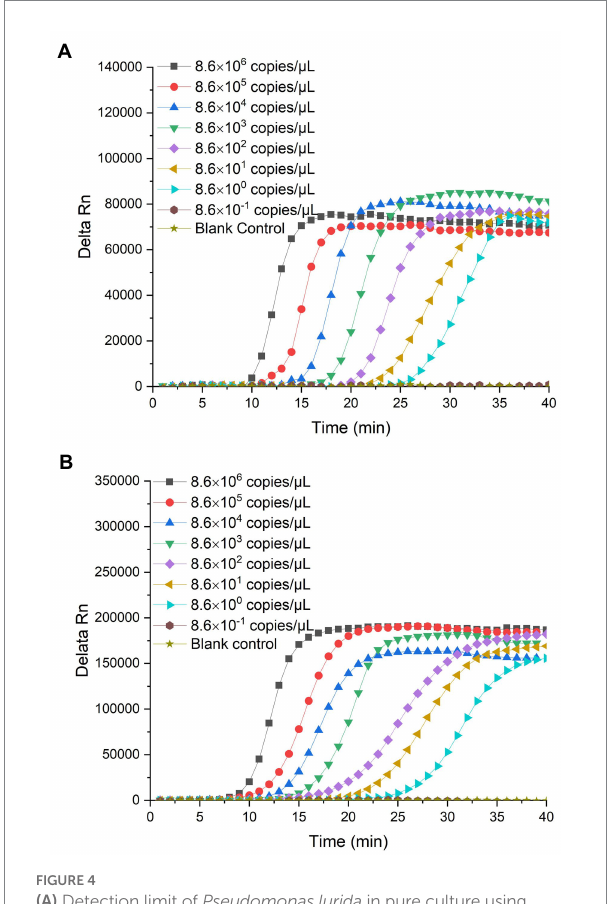
FIGURE 4 (A) Detection limit of Pseudomonas lurida in pure culture using RealAmp based on the gyrB gene. (B) Detection limit of Pseudomonas lurida in pure culture using RealAmp based on the aprX